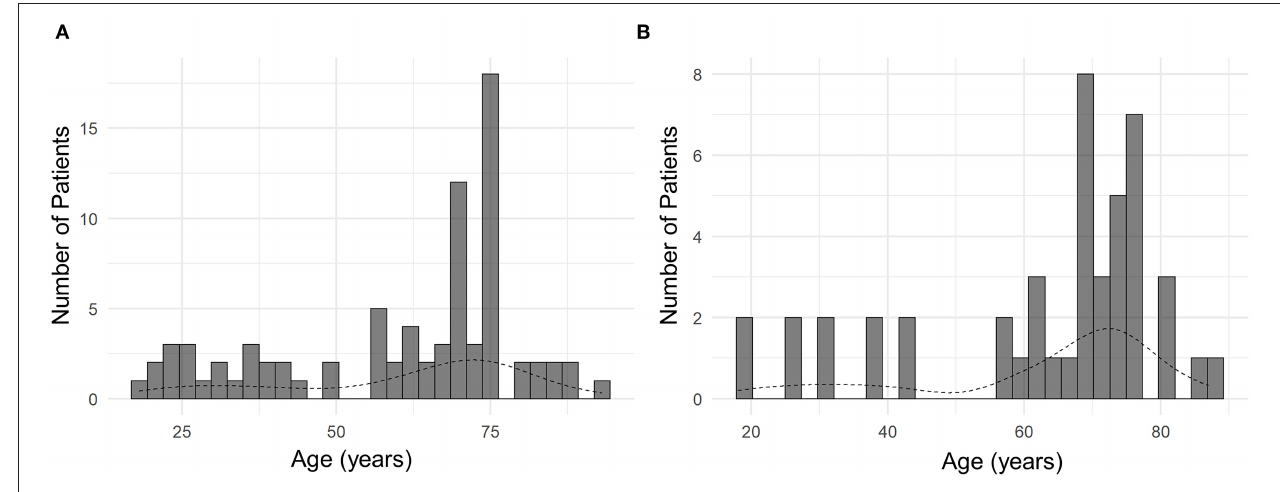
FIGURE 1 | Distribution of patients by age. (A) All patients. (B) Patients with chorea.